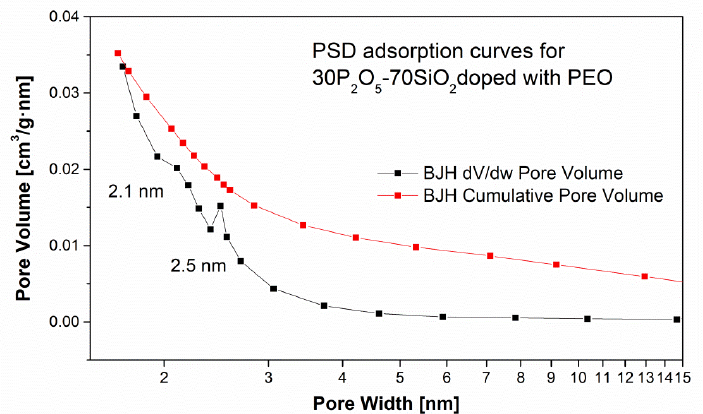
Figure 10. Pore size distribution vs. pore volume (incremental and cumulative) for 30P 2 O 5 -70SiO 2 + 0.5% PEO 1M samples.